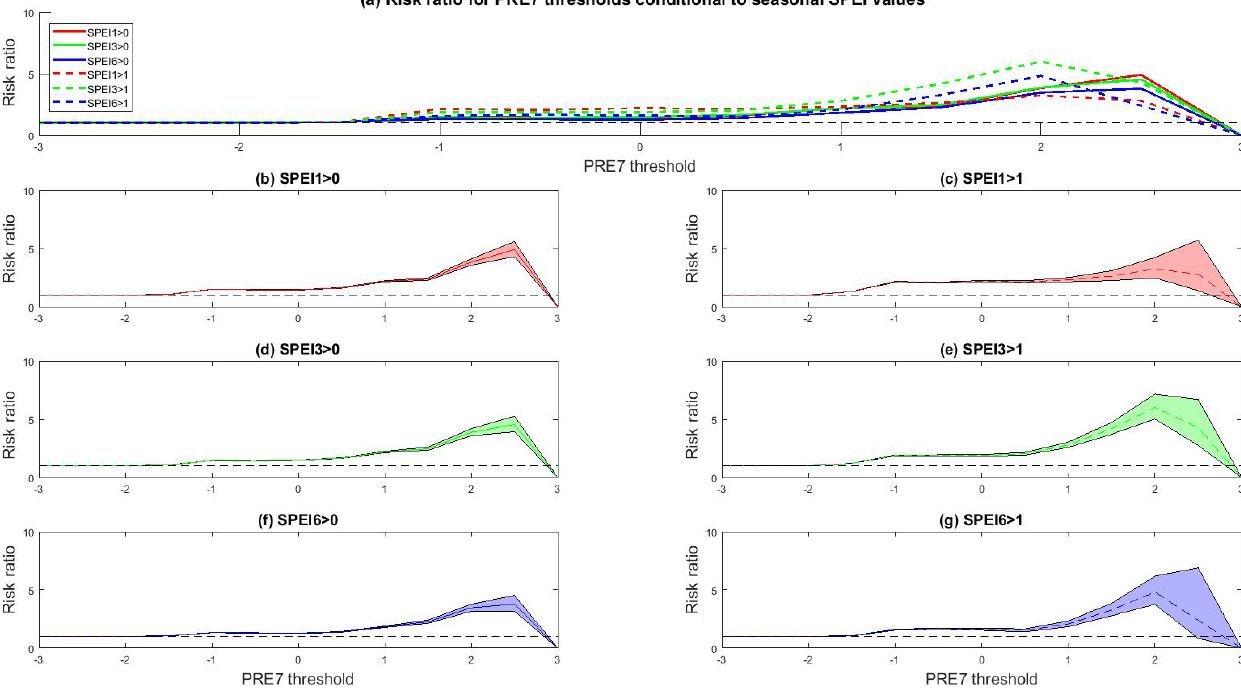
Figure 9. Risk ratio between F and NF for given PRE7 thresholds conditional to seasonal SPEI values (SPEI1 > 0, red solid; SPEI > 1, red dashed; SPEI3 > 0, green solid; SPEI3 > 1, green dashed; SPEI6 > 0, blue solid; SPEI6 > 1, blue dashed) (a) and their confidence intervals are shown (b–g) . The horizontal dashed line shows the risk ratio of